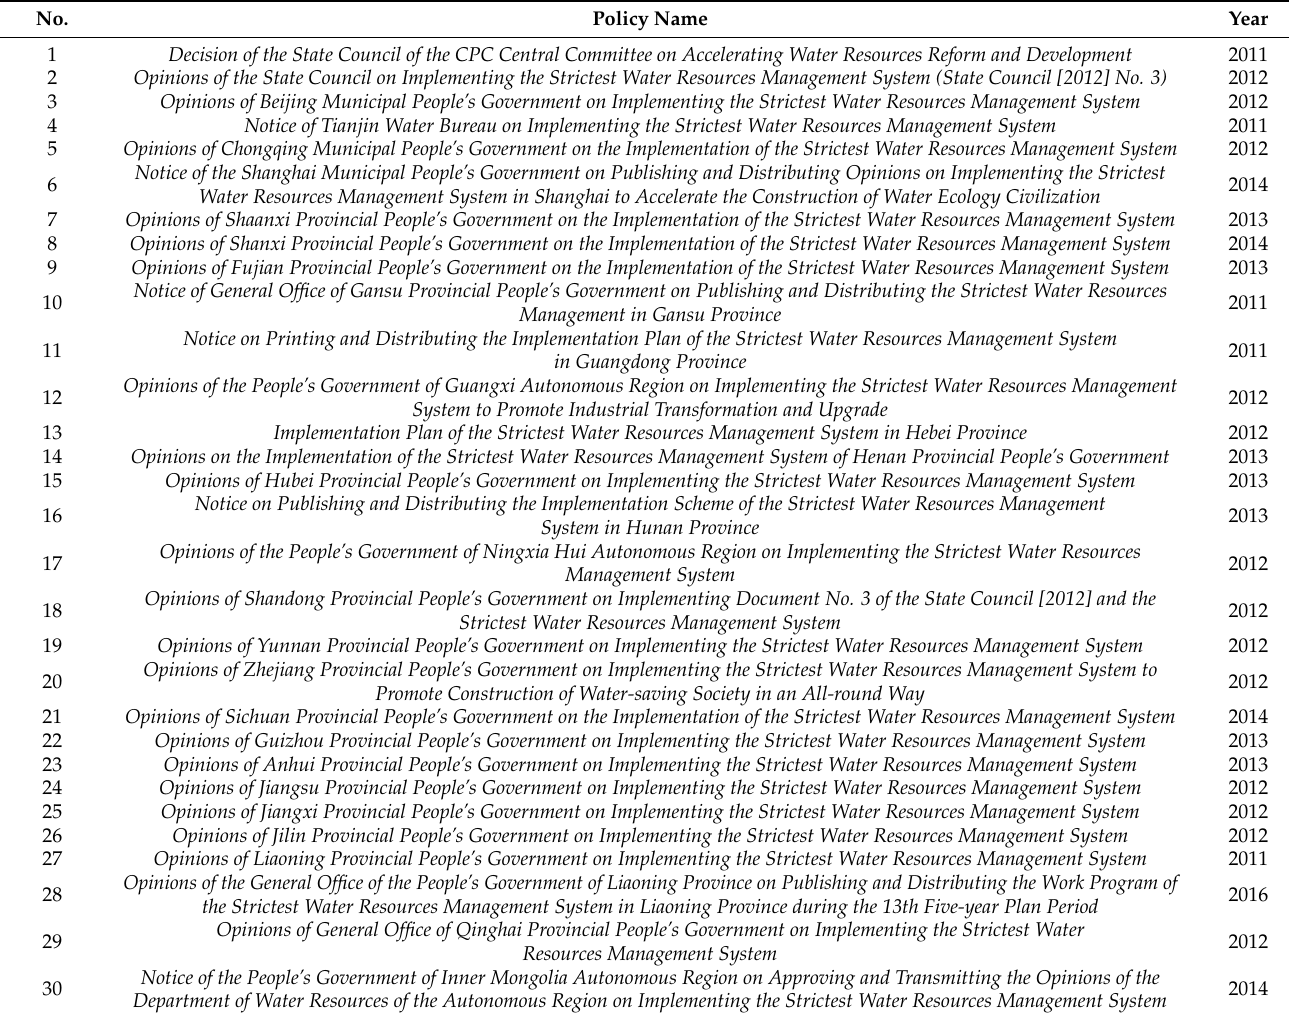
Table 2. The strictest water resources management policy text.